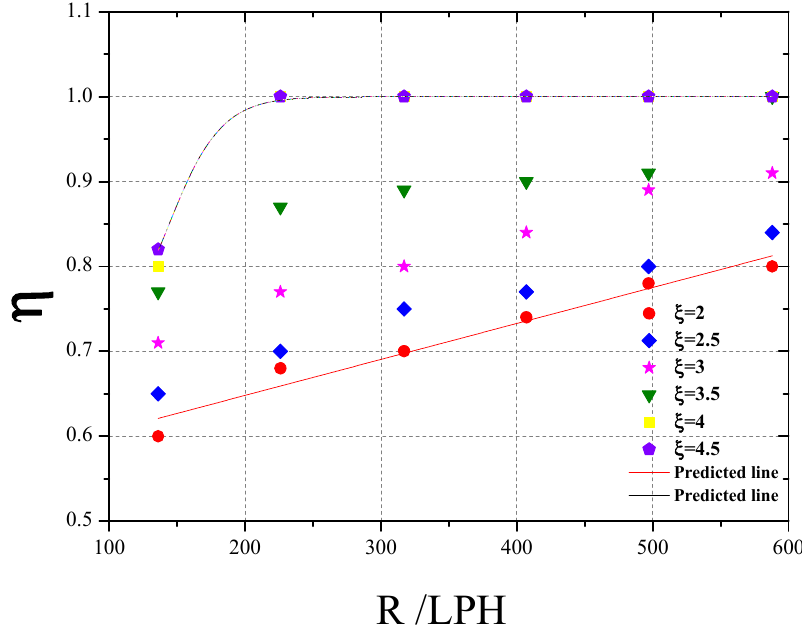
Figure 8. Dimensionless maximum oscillation distance of bubbly flow at the various gas volume fluxes.